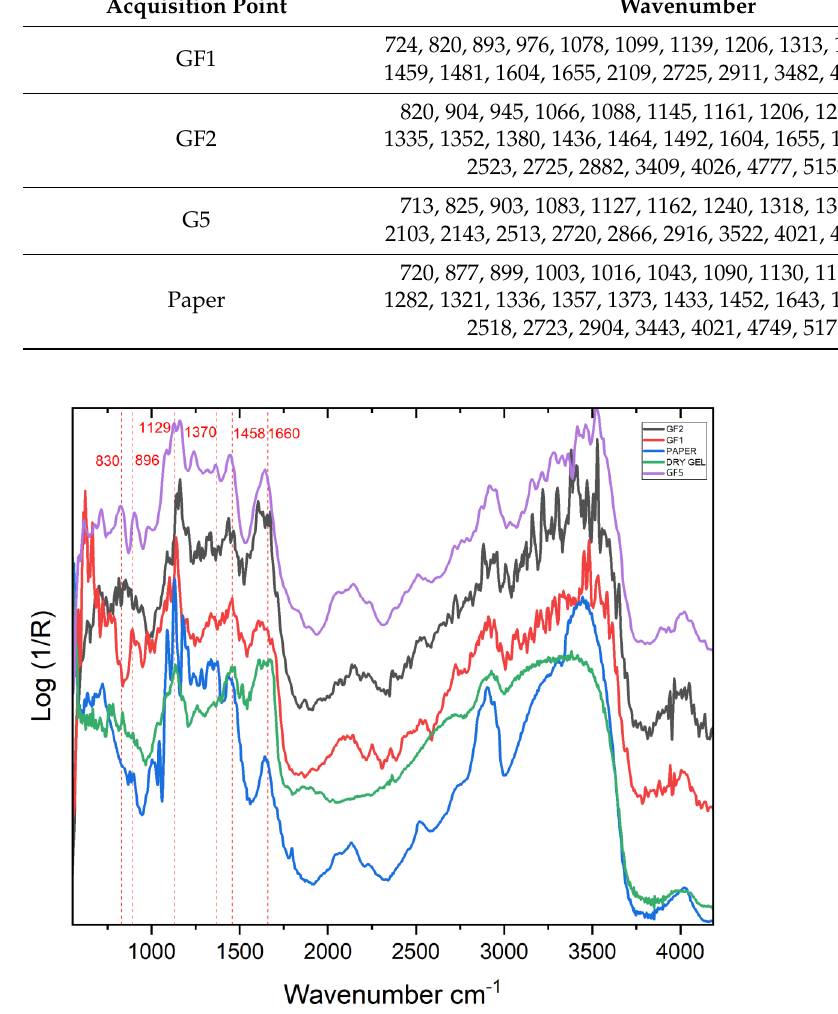
Figure 8. FTIR spectra of points GF1, GF2, and GF5; of the paper obtained from the original artwork of Gioli; and of the reference dry gel. Signals of the dry gel are highlighted.